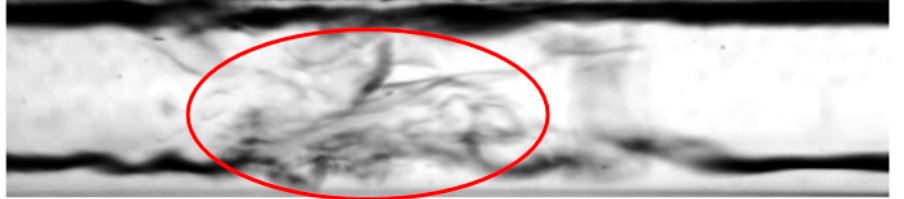
Figure 11. Frothy flow formation when a wave is refracted in a annular ‐ wave structure during the condensation of the HFE7000 refrigerant in a minichannel with a diameter d h = 2.0 mm ( G = 203 kg/m 2 s; x = 0.011; ϕ = 0.66; t s = 33 °C).